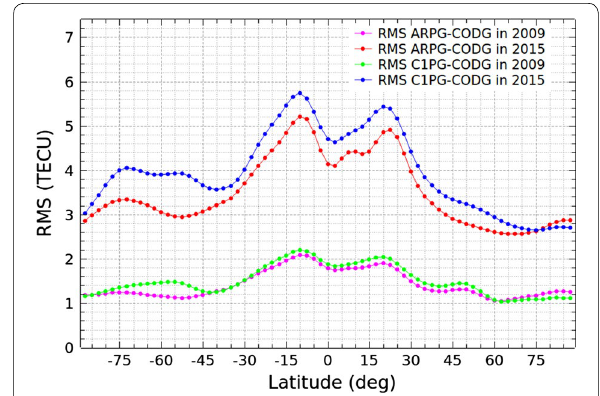
Fig. 6 RMS of the differences between forecasting products and the final CODG in 2009 and 2015. The magenta and green dotted lines depict the RMS of the differences between ARPG and CODG and those between C1PG and CODG in 2009, respectively. Red and blue dotted lines depict the RMS of the differences between ARPG and CODG and those between C1PG and CODG in 2015, respectively